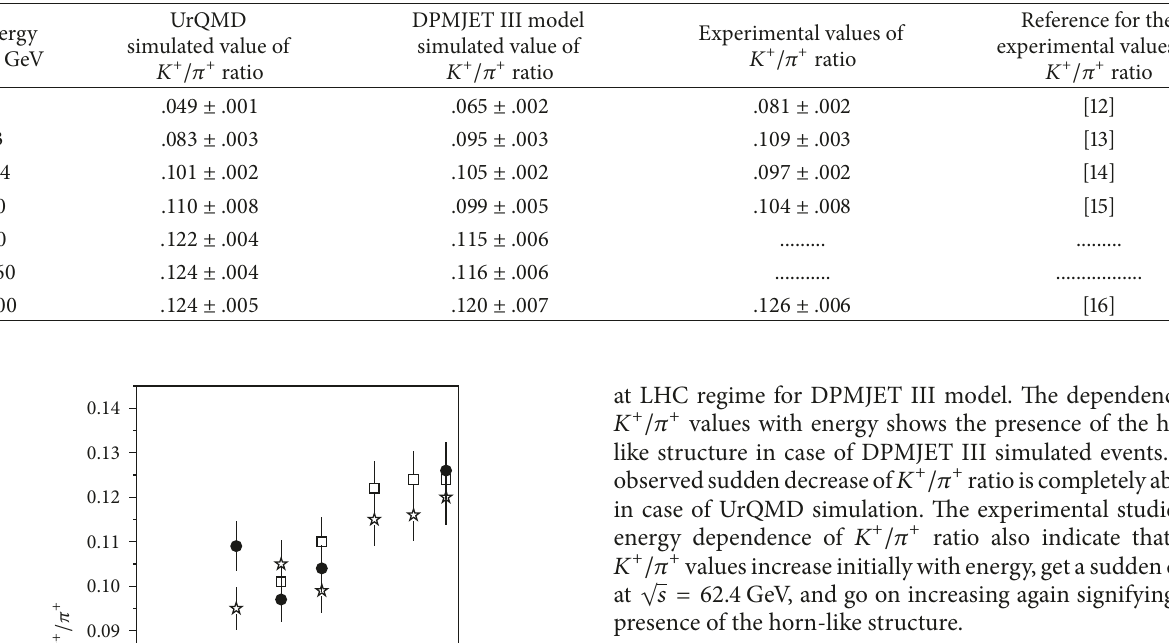
Table 1: It represents the values of 𝐾 + /𝜋 + ratio in pp collisions at √𝑠 = 6.3 GeV to 7TeV in the framework of UrQMD, DPMJET III, and the experimental values.